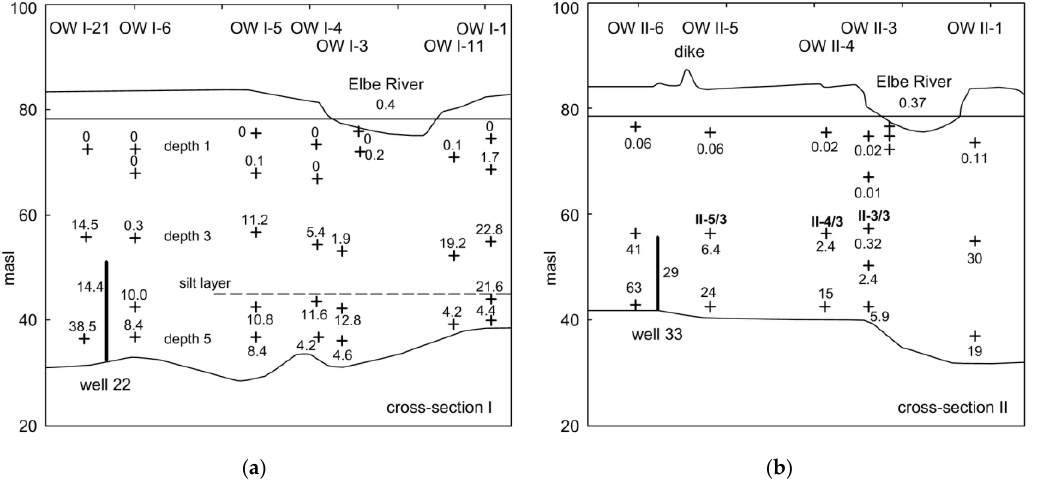
Figure 9. Mean total iron concentrations in mg/L at ( a ) cross-section I and ( b ) cross-section II in Torgau, 1995-97 (n > 12), looking downstream.